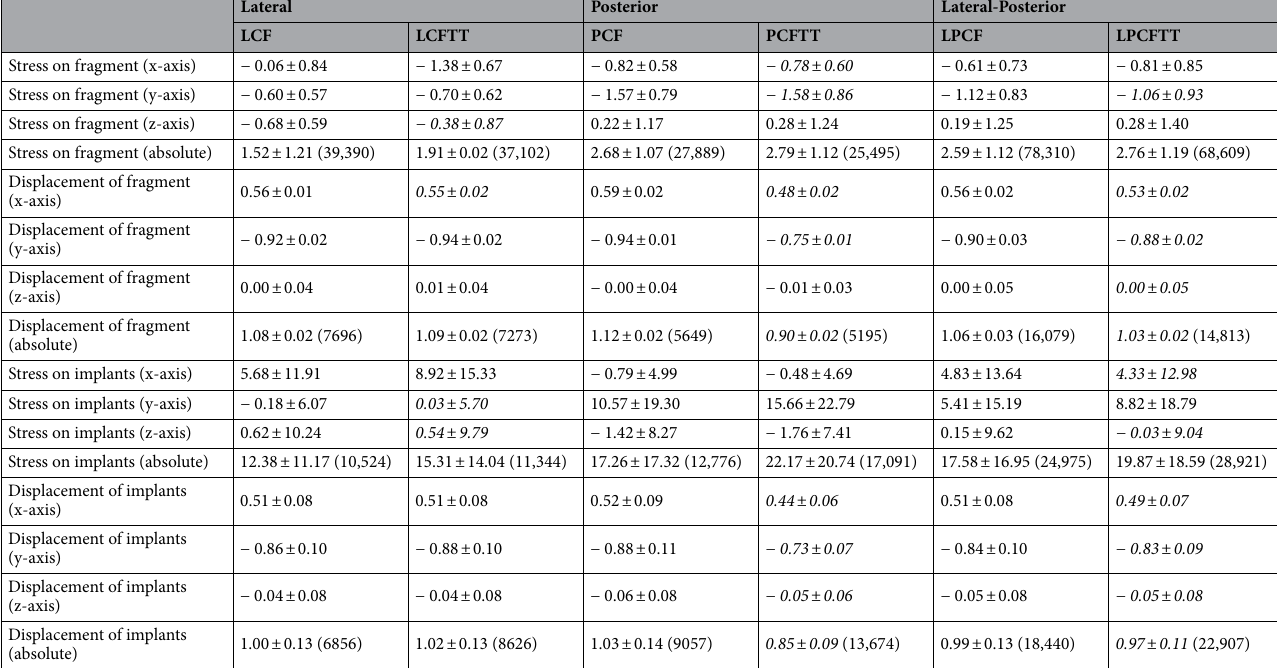
Table 1. Von Mises stress and displacement of cancellous fragment and implants of fracture models with and without TT. The content inside parentheses was the number of extracted nodes or elements. Data were expressed as mean ± standard deviation. The values of fracture models with TT were compared with corresponding models without TT. The unit of stress and displacement is MPa and mm respectively. The data of corresponding models were not statistically significant or the models with TT were statistically significant (P < 0.05) from the matching models without TT were shown in italics.